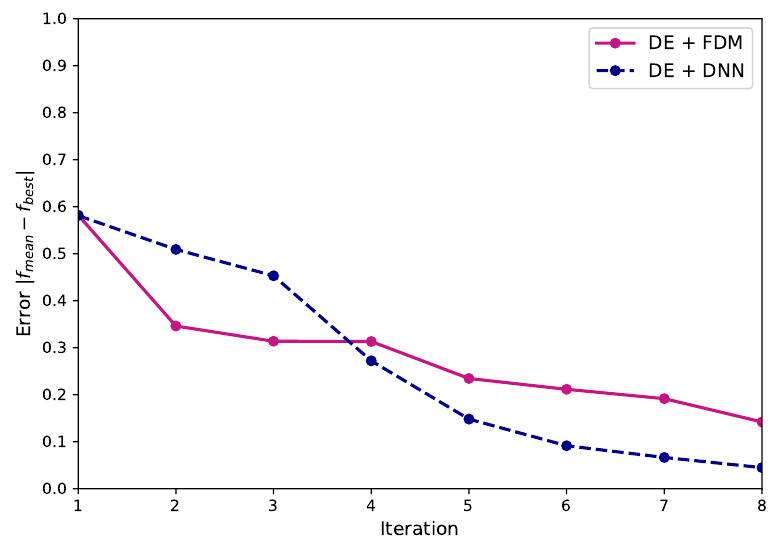
Figure 24. Comparison of the force densities of the 3D truncated icosahedron tensegrity using FDM, DNN-based form-finding model with DE algorithm and analytical solution [6].